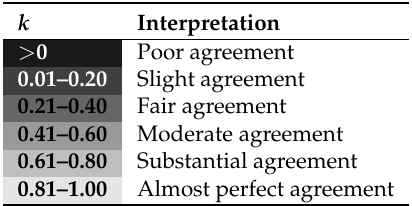
Table 5. Interpretation of the Fleiss’s kappa.